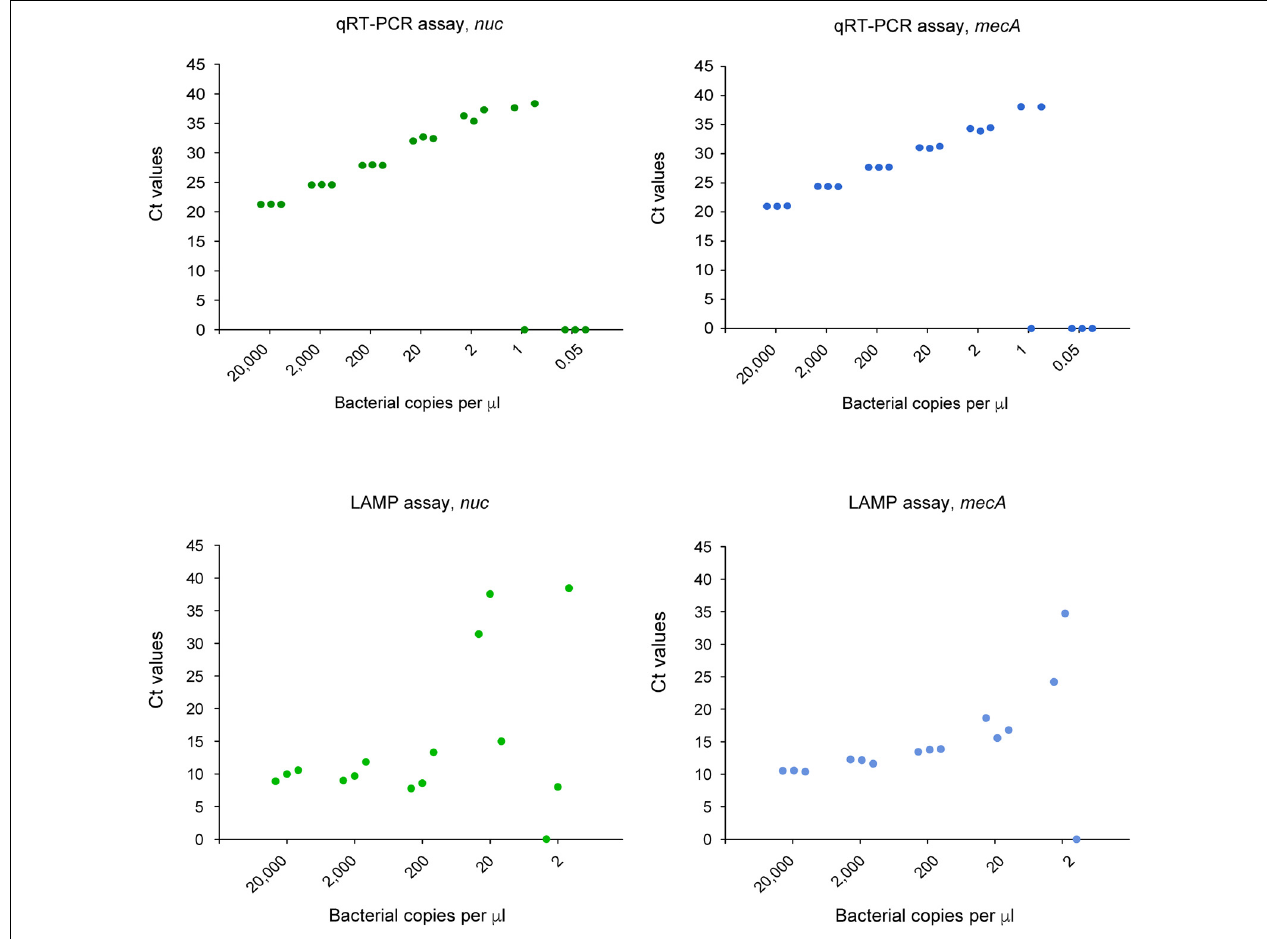
FIGURE 5 | LoD of the qRT-PCR and CRISPR-LAMP assay for nuc and mecA .